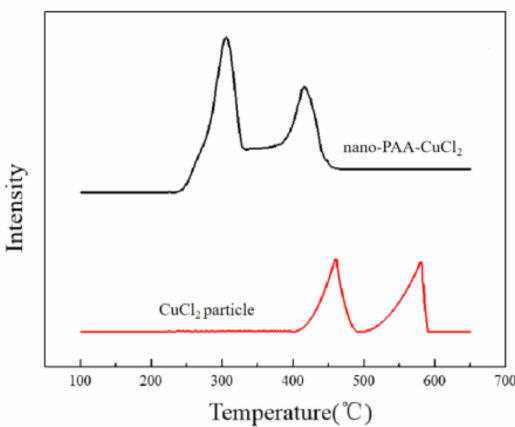
Figure 13. H 2 -TPR profiles of nano-PAA-CuCl 2 composite and CuCl 2